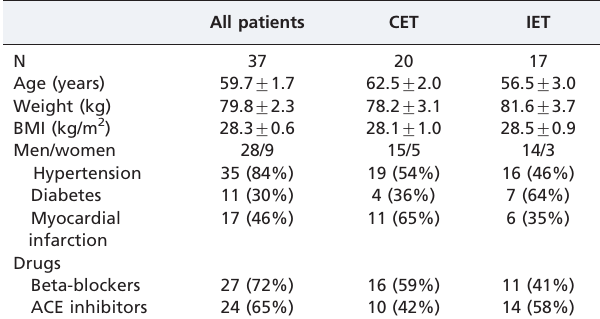
Table 1 - Patient characteristics. All